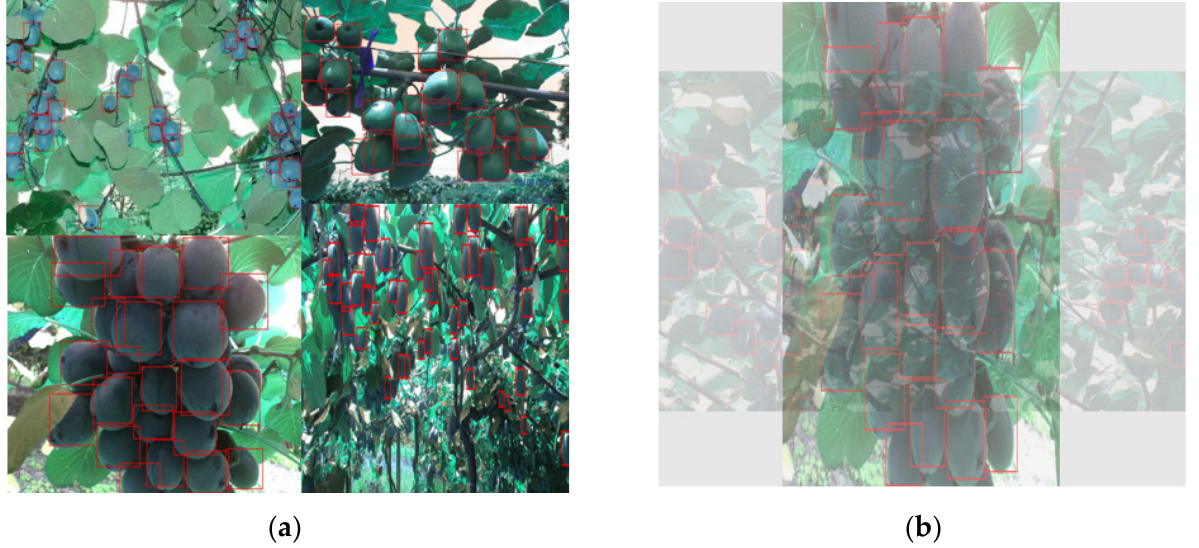
Figure 4. Data enhancement effects: ( a ) mosaic data enhancement and ( b ) mix-up data enhancement.